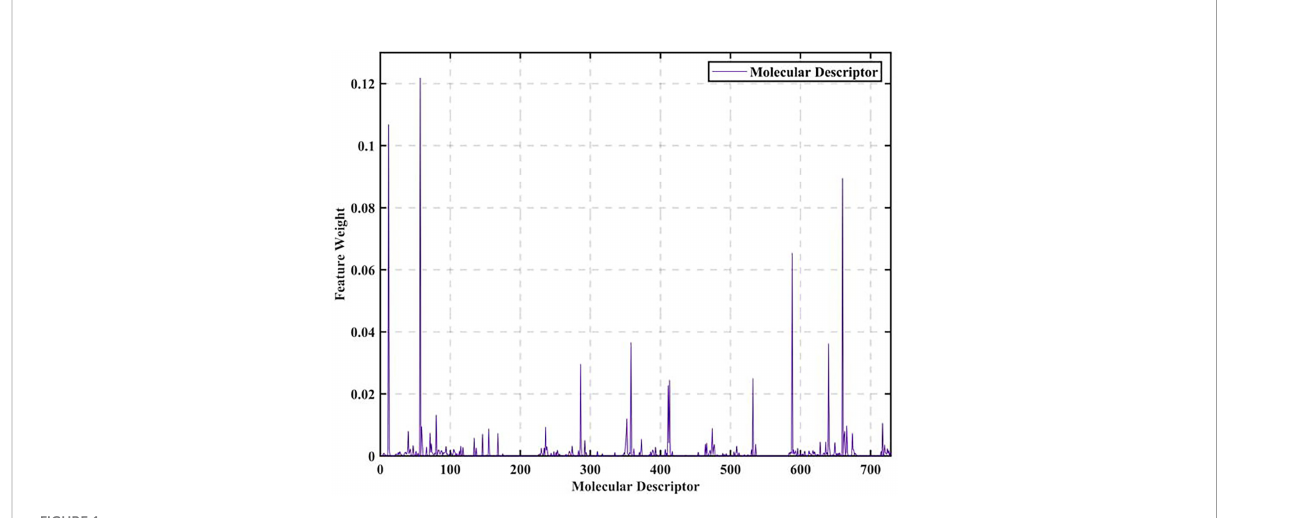
FIGURE 1 Molecular descriptor feature